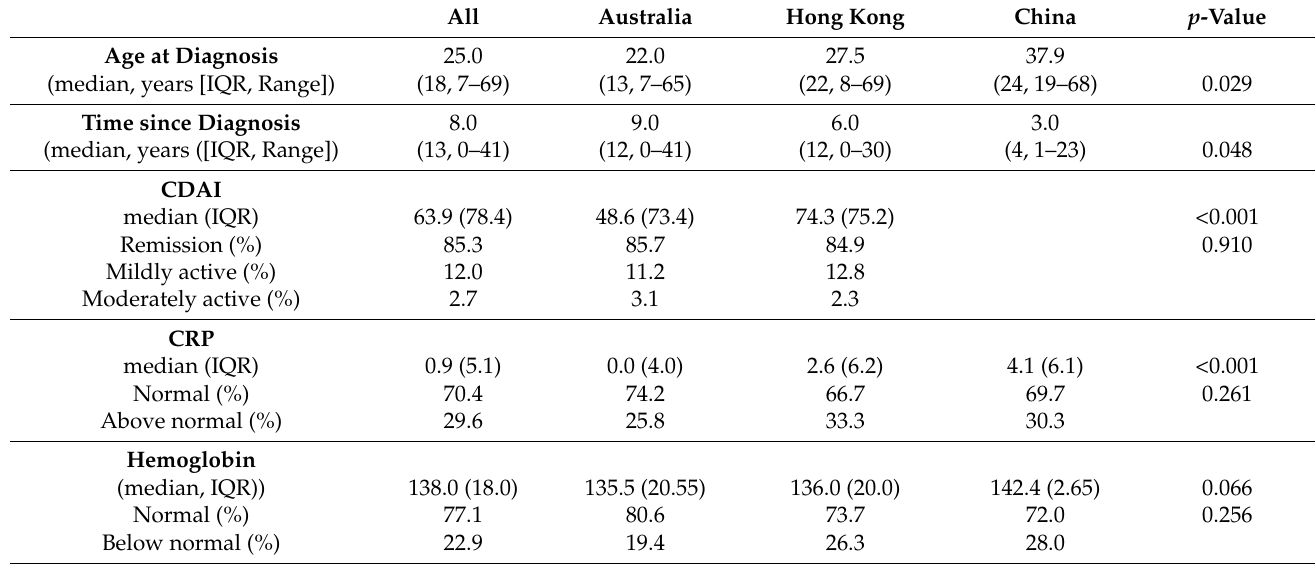
Table 2. Disease diagnosis and disease activity of Australia and Hong Kong Crohn’s disease participants.